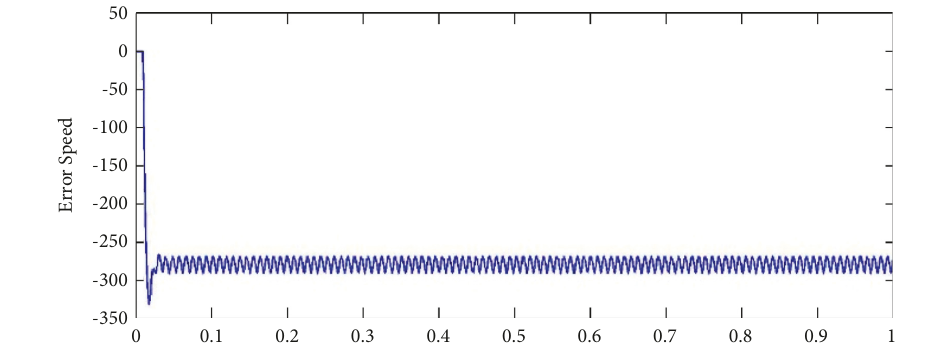
Figure 16: Rotor speed of BLDC